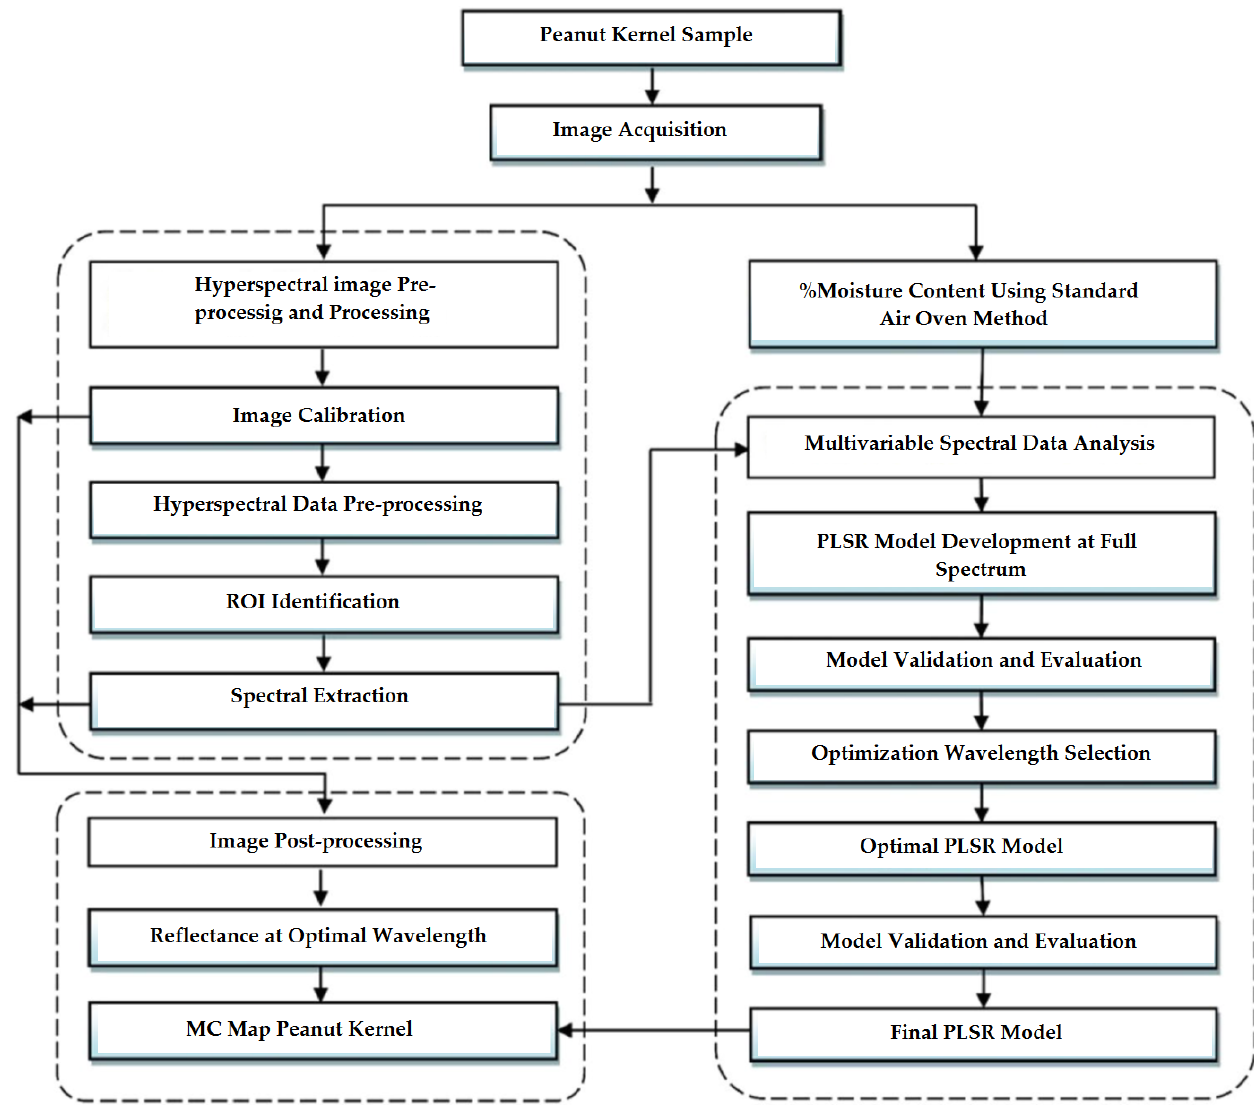
Figure 5. General steps involved in the